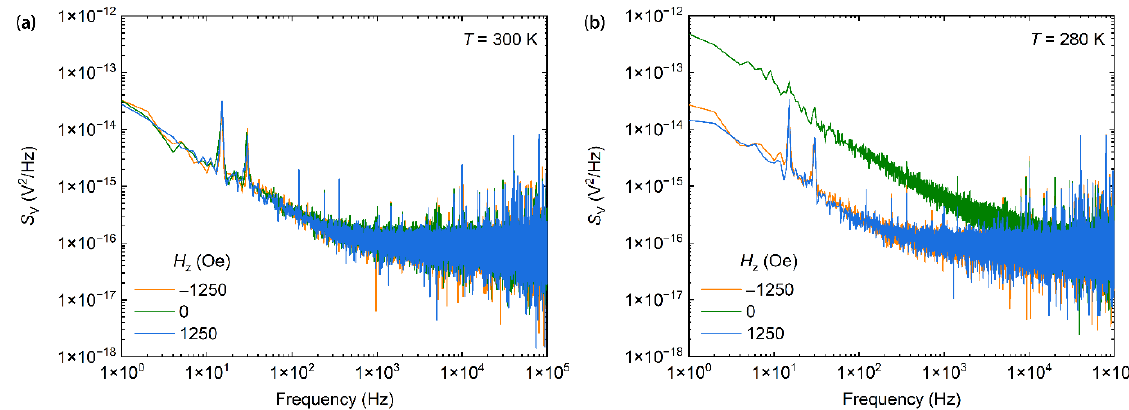
Figure 5. ( a ) Hall voltage noise spectra measured at 300 K and at different perpendicular magnetic fields. ( b ) Hall voltage noise spectra measured at 280 K and at different perpendicular magnetic fields.